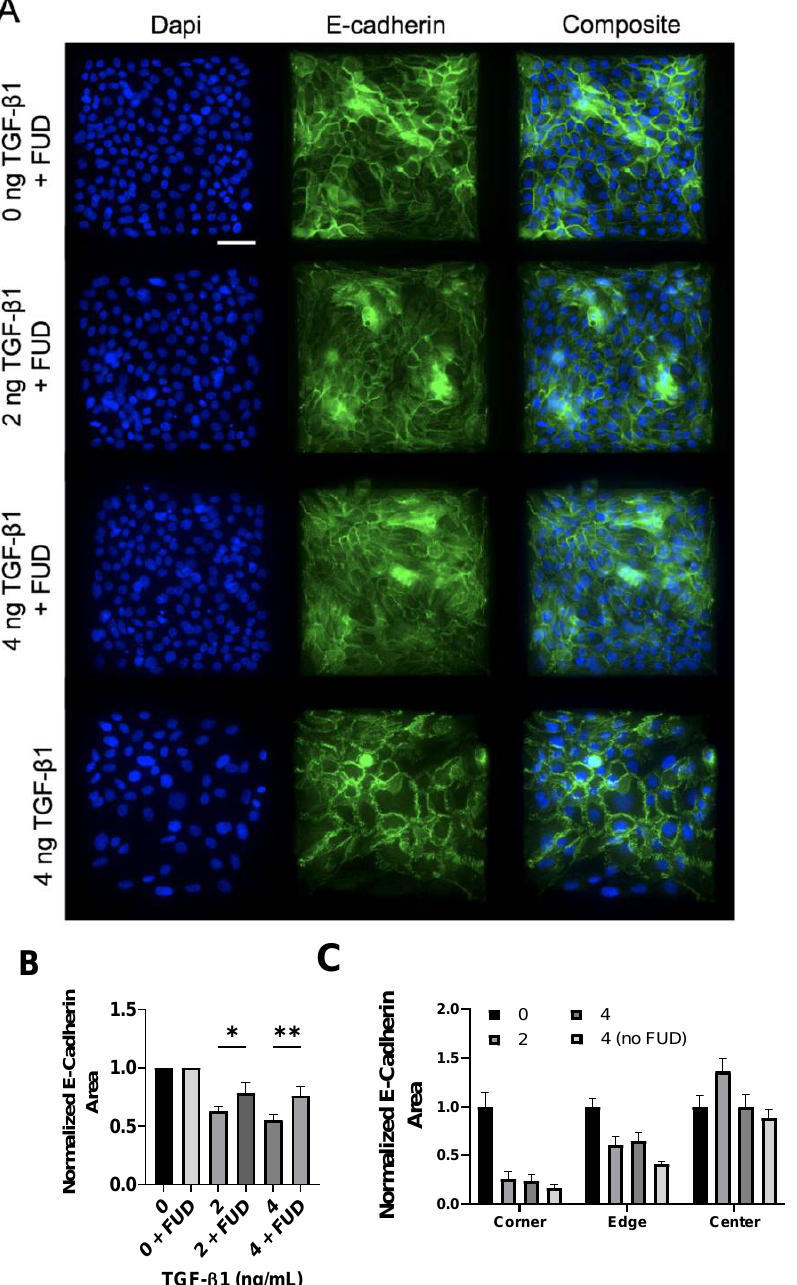
Figure 9. Inhibition of FN fibrillogenesis partially blocks TGF- β 1-induced E-Cadherin loss, but main- tains spatial gradients of E-Cadherin. ( A ) Immunofluorescence images of MCF10As after 48 h of treatment with FUD and increasing concentrations of TGF- β 1. Ab staining for nuclei (blue) and E-Cadherin (green). Scale bar 50 µm. ( B ) Quantification of E-Cadherin area. E-Cadherin area per